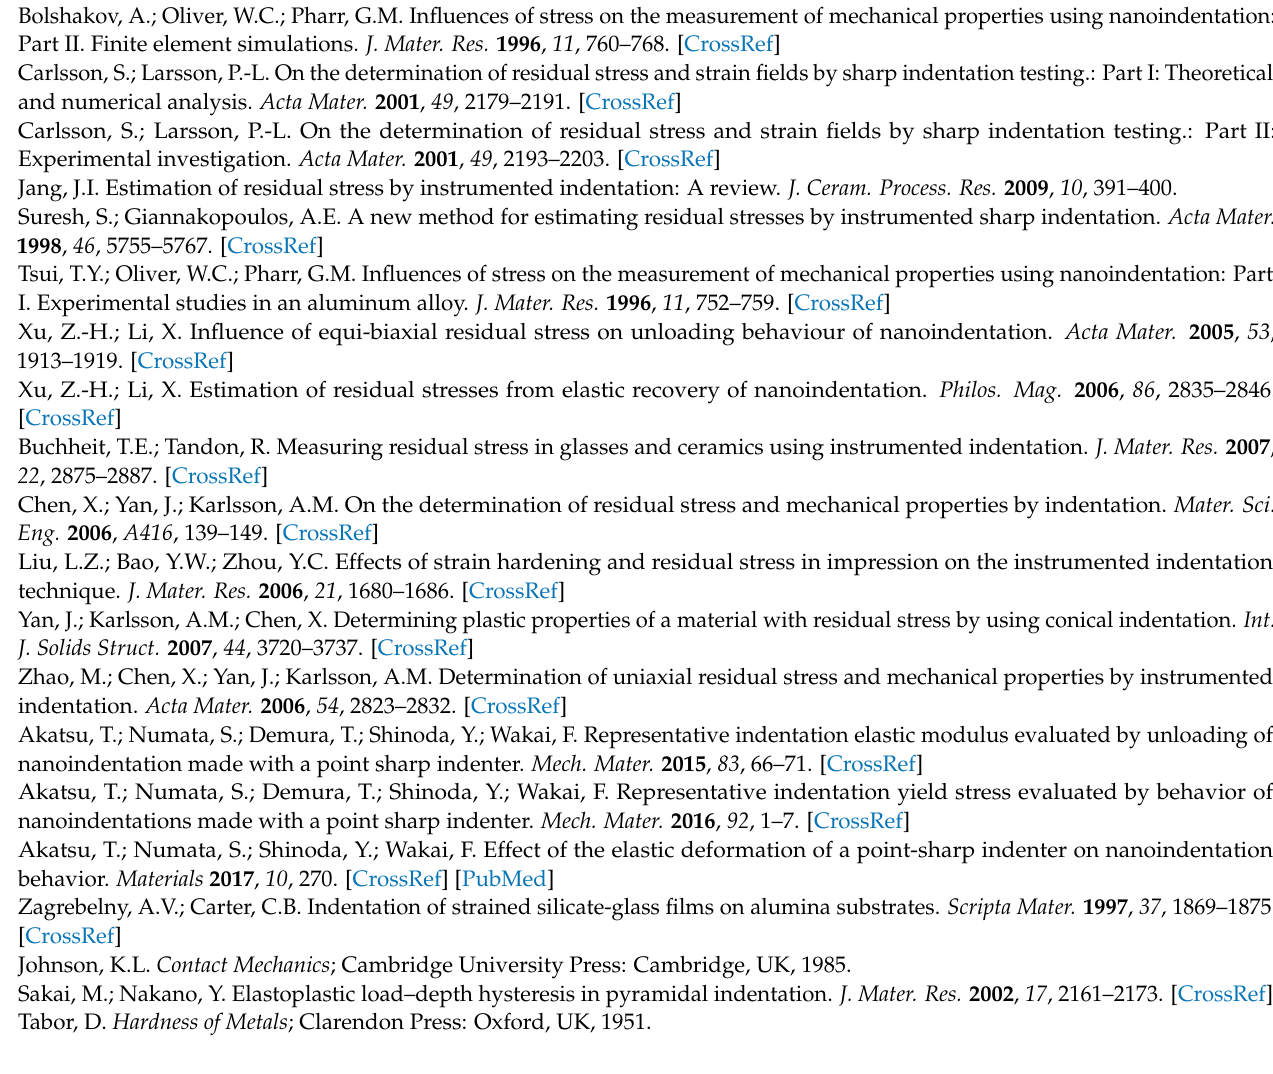
Tabor, D. Hardness of Metals ; Clarendon Press: Oxford, UK,